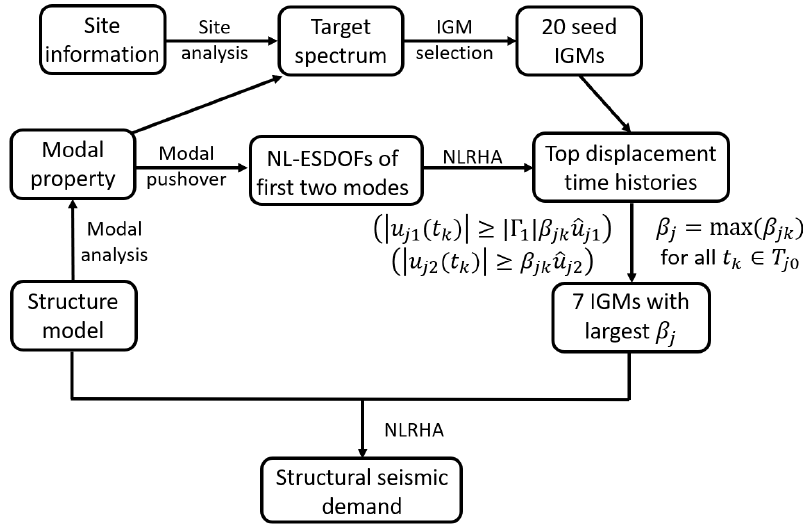
Figure 1. Flowchart of MGMS procedure of wall structures.